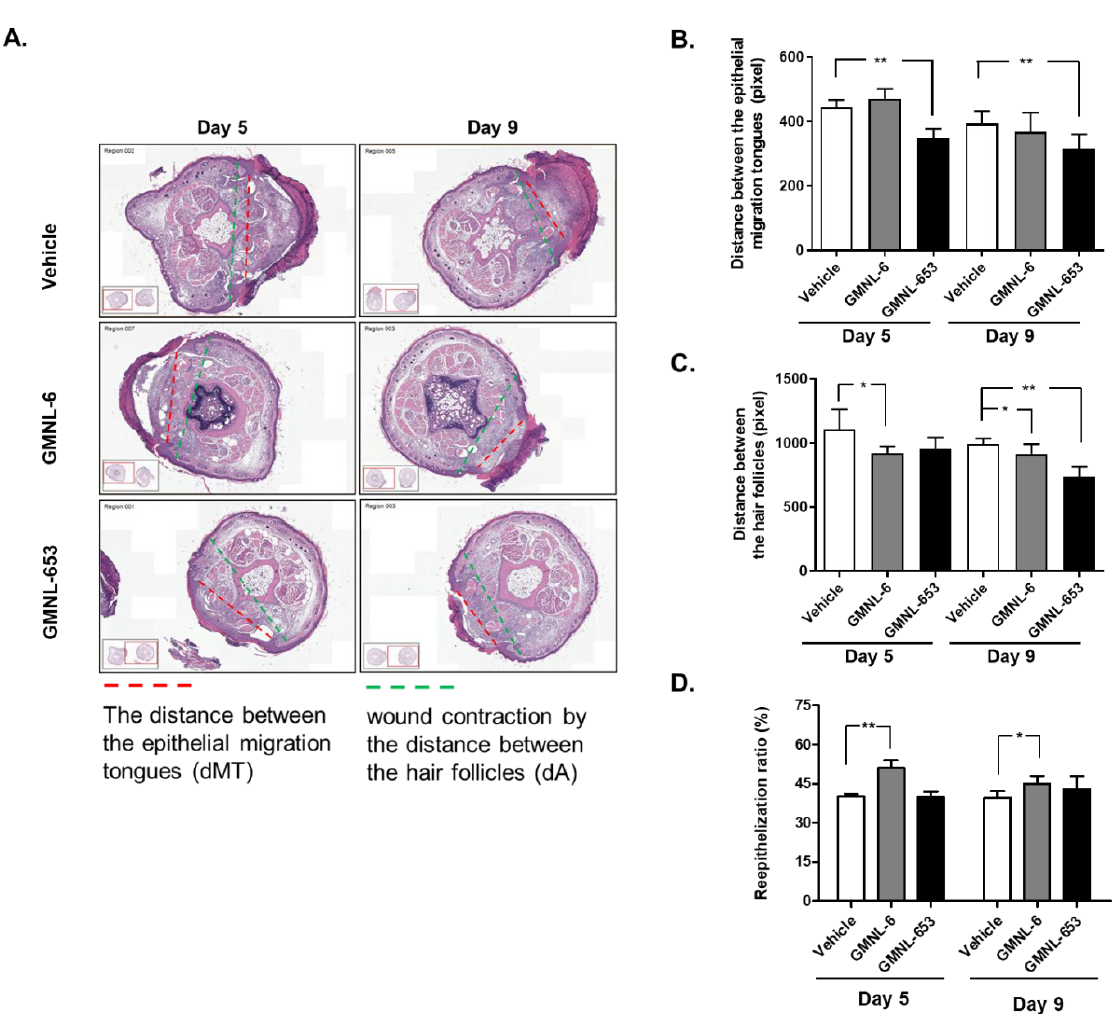
Figure 4. Probiotics GMNL-6 and GMNL-653 treatments provide prominent tail-wound healing recovery ability. The experimental tail wounds were introduced as the descriptions in Materials and Methods section. ( A ) The tail specimens were taped at Day 5 or Day 9 after wound introduction and performed H&E staining. The wound re-epithelialization or the wound contract was determined by the distance between the epithelial migration tongues (dMT, red dashed lines) or the distance between the hair follicles nearby the wound bed (dA, green dashed lines), respectively. ( B , C ) The quantitative results of dMT ( B ) or dA ( C ) were presented. ( D ) The reepithelialization ratio was calculated as the formula of dMT/dA and was presented as percentage of total wound length. For each group, n = 4; values present mean ± SEM, * p < 0.05, ** p < 0.01 when compared with the vehicle treatment.